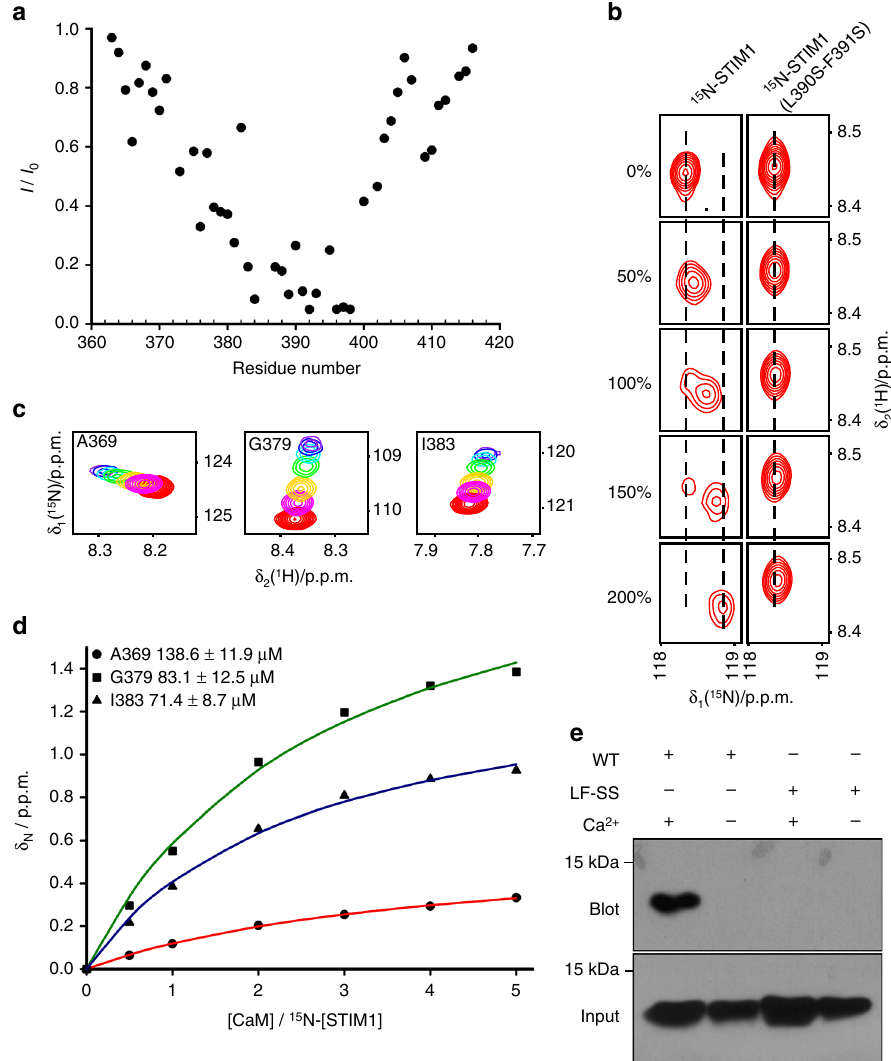
Fig. 3 Binding site of Ca 2+ -CaM to SOAR. a Plot of cross-peak intensity ratio, I / I 0 , as a function of amino acid sequence, where I and I 0 are cross-peak intensities in the 15 N-HSQC spectra that were recorded for 0.1 mM 15 N-STIM1 (363 – 416) in the presence and absence of 0.05 mM CaM, respectively. b Interaction comparison of 15 N-STIM1 (363 – 416) WT and the 15 N-STIM1 (363 – 416) L390S-F391S mutant with Ca 2+ -CaM. The cross-peak of residue S400 in the 15 N-HSQC spectra was monitored with respect to the [CaM]/[STIM1 (363 – 416) WT or mutant] molar ratio (0, 0.5, 1.0, 1.5, 2.0 from top to bottom). c Chemical shift changes in residues A369, G379 and I383 in the 15 N-HSQC spectra recorded for 0.1 mM 15 N-STIM1 (363 – 416) L390S-F391S mutant, with CaM concentrations ranging from 0 to 0.5 mM. d Dissociation constant, K d , of the STIM1 (363 – 416) L390S-F391S mutant and CaM calculated from the chemical shift changes of backbone amide nitrogen atoms with respect to the [CaM]/[STIM1 (363 – 416) L390S-F391S mutant] molar ratio. e CaM-Sepharose pull-down experiment of SOAR WT and mutant